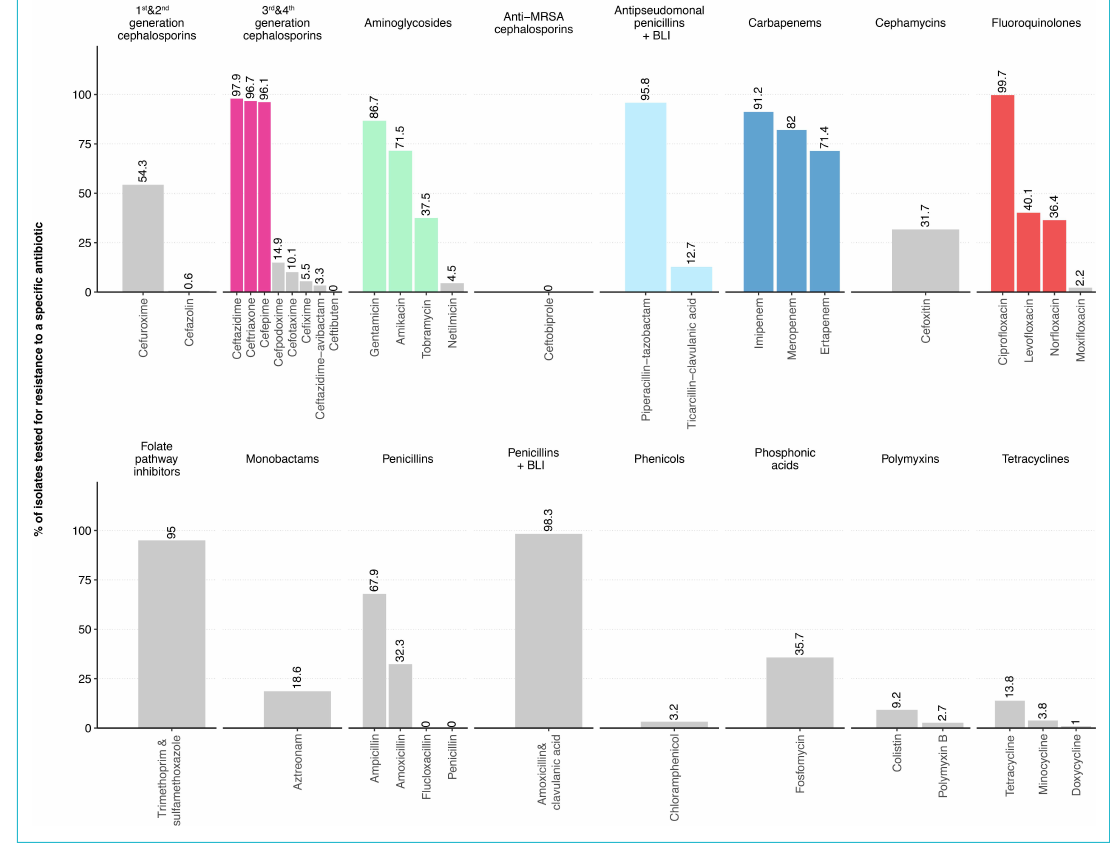
Figure 1: Proportion of Enterobacterales blood culture isolates tested for specific antibiotics among the antibiotic categories defined by the ECDC. The most frequently tested antibiotics in the five antibiotic categories important for the definition of GN-MDRO are highlighted in colour. BLI, β-lactamase inhibitor; MRSA, methicillin-resistant Staphylococcus